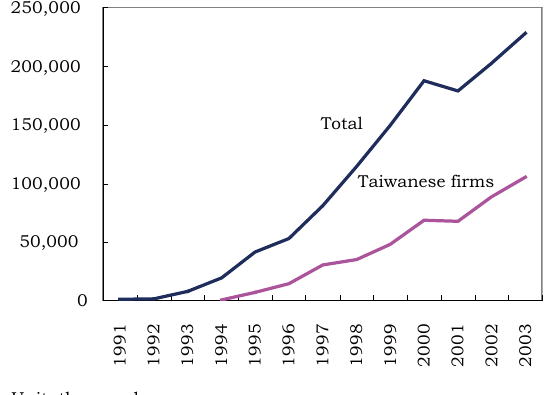
Figure 1. Shipment of optical disk drive for